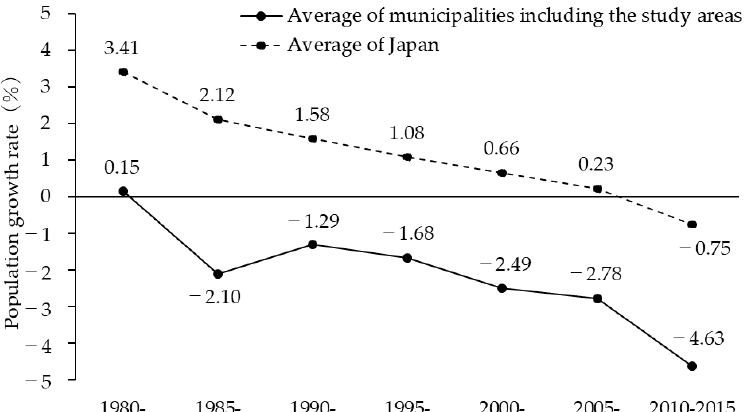
Figure 5. Population growth rate in the municipalities including the study areas. (Date sources: [31]).